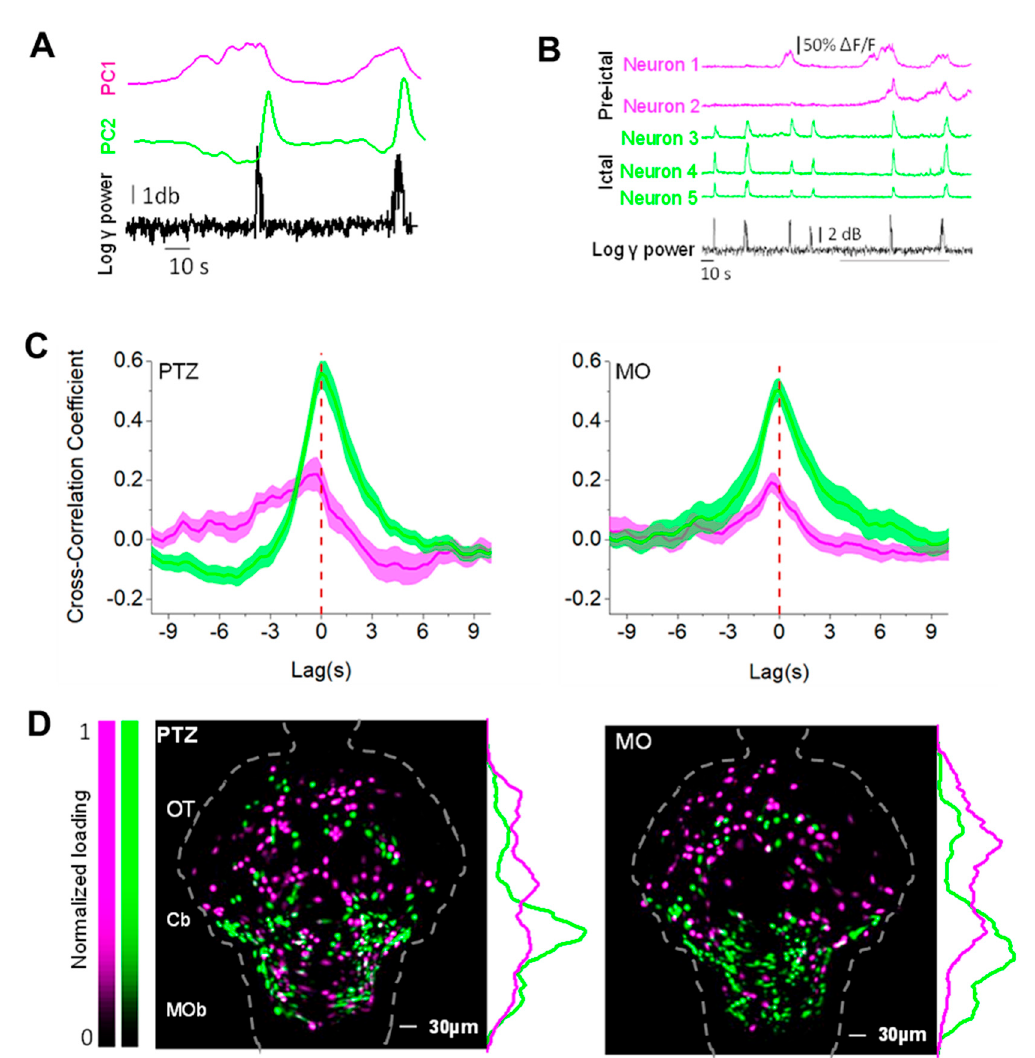
Figure 6. Principal component analysis (PCA) analysis identifies two di ff erent neuronal populations. ( A ) Population activity profiles represented by the first two PCA components describing the Ca 2 + dynamics of single neurons. The black trace represents the corresponding RMS power. ( B ) Representative ∆ F / F0 activity selected from single neurons best described by either PC1 (magenta) or by PC2 (green) in a PTZ-treated larva. PC1 neurons’ activation precedes the LFP bursts, whereas PC2 neurons activate during the LFP peaks. The grey bar indicates the events magnified in panel A. ( C ) Mean cross-correlograms of the two selected PCs with the aligned RMS power (n = 15 events from 4 morphants and n = 16 events from 4 PTZ larvae). ( D ) Cumulative maps for the PTZ (n = 4) and the MO (n = 4) larvae. Each cell is represented by its normalized loading (see the Materials and Methods Section) with respect to the PC1 and PC2. The plots on the right represent the normalized signal (arbitrary units) of the two-cell population along the rostro-caudal axis. The distribution of the two functional populations are significantly di ff erent in both models ( p = 0.002 for the morphant and p < 0.0001 for the PTZ, two-samples Kolmogorov–Smirno ff test). In order to standardize the images, we registered the maps into a reference brain mask using a non-rigid image registration algorithm (see the Materials and Methods